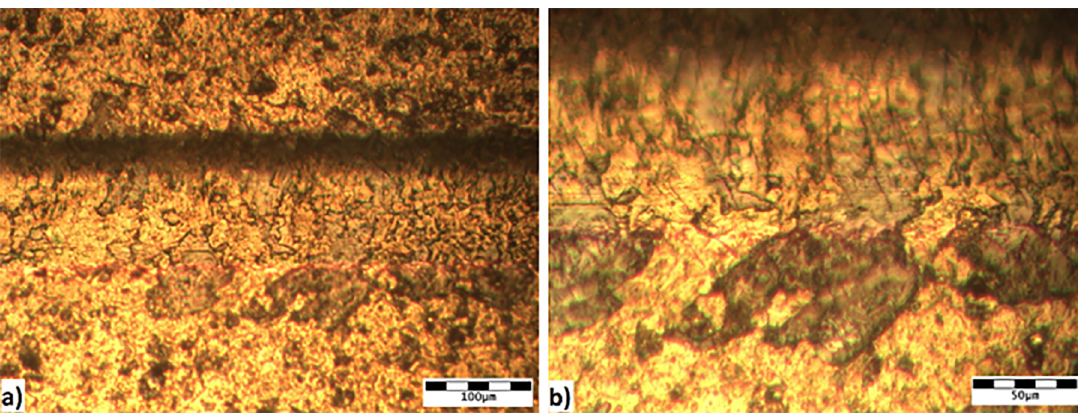
Figure 7. Scratch Test critical load: Cond III 20 N a) 200x, b)